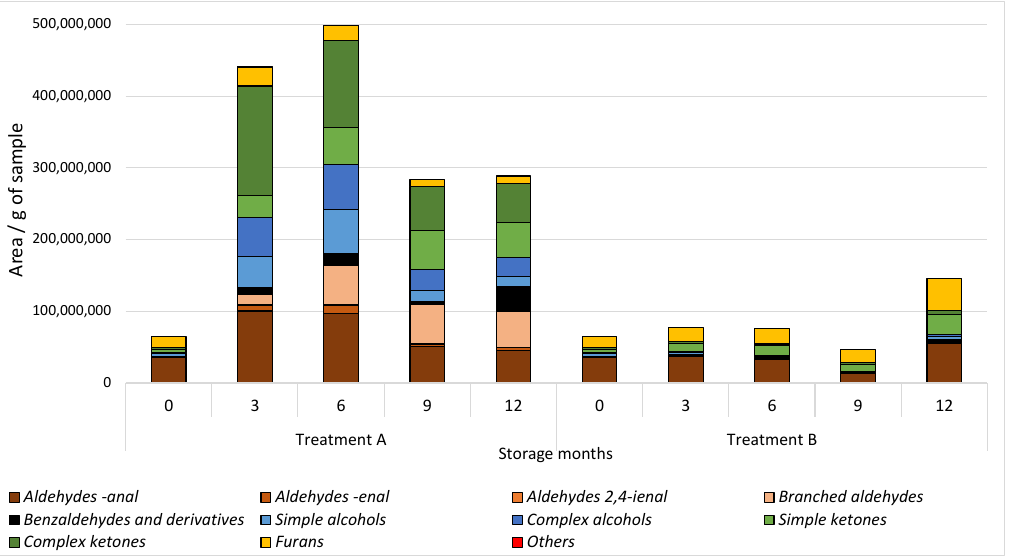
Figure 1. Profile of volatile compounds by chemical family during the ageing ( n = 3). Treatment A: 20 °C—Light, Treatment B: 30 °C—Dark.